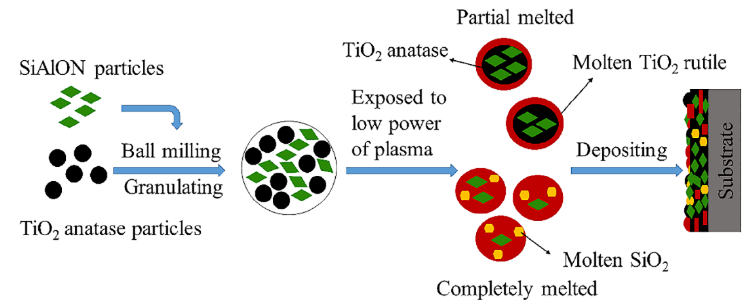
Figure 6. The schematic diagram of the spray coating design of TiO 2 –SiAlON.